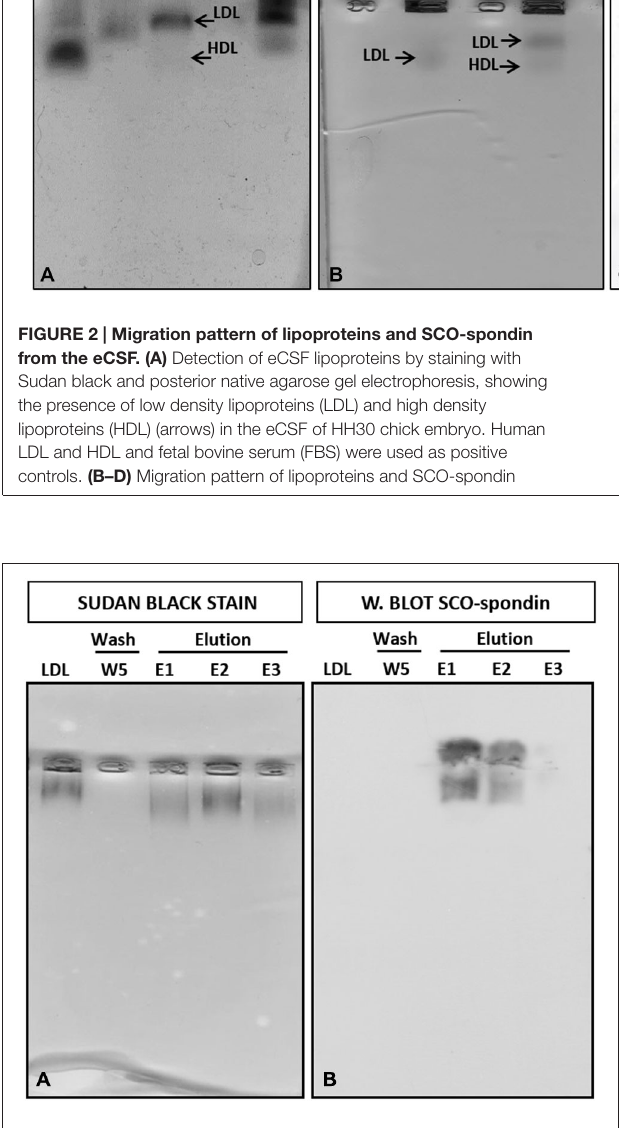
FIGURE 3 | Coimmunoprecipitation of LDL and SCO-spondin from the eCSF . (A) Native agarose gel electrophoresis of eCSF from HH23 chick embryo immunoprecipitated with SCO-spondin antibodies. Lane 1: LDL commercial. Lane 2: W5: last wash of the immunoprecipitate, revealing the absence of lipoproteins. Lane 3–5: Elution fractions of the immunoprecipitate, showing the presence of LDL. (B) Western blot with anti-SCO-spondin of the gel shown in (A) , revealing the presence of this protein in the eluted